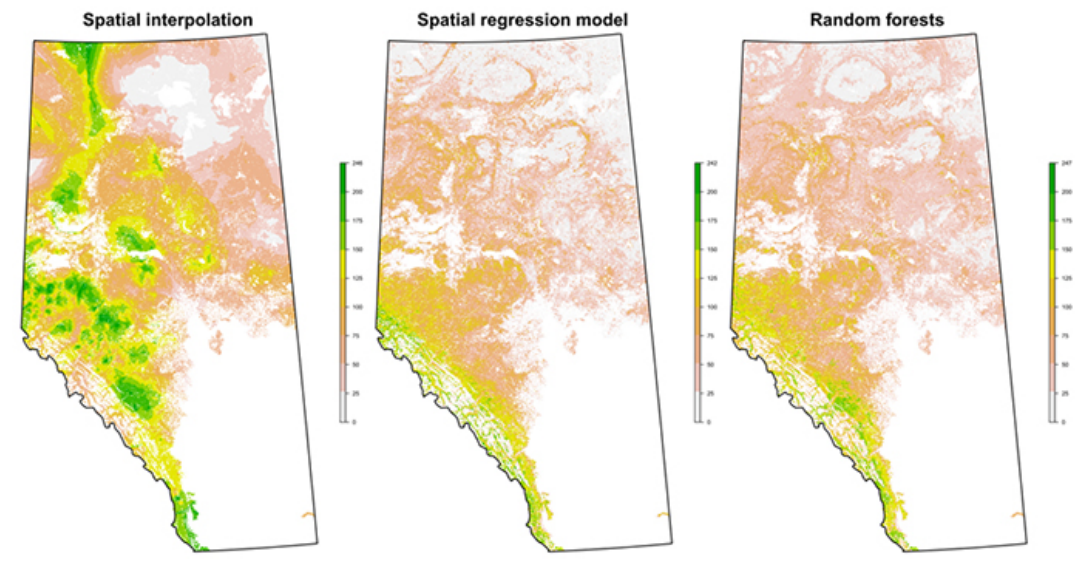
Figure 3. The estimates of total AGB density (Mgha − 1 ) using spatial interpolation, spatial multiple regression model, and decision-tree- based modeling with random forests algorithm (Projection: UTM zone = 11; spatial resolution: 1km). Table 2. Validation statistics for four different approaches for total tree AGB estimation. Methods for biomass estimation Non-spatial regression model Spatial regression model